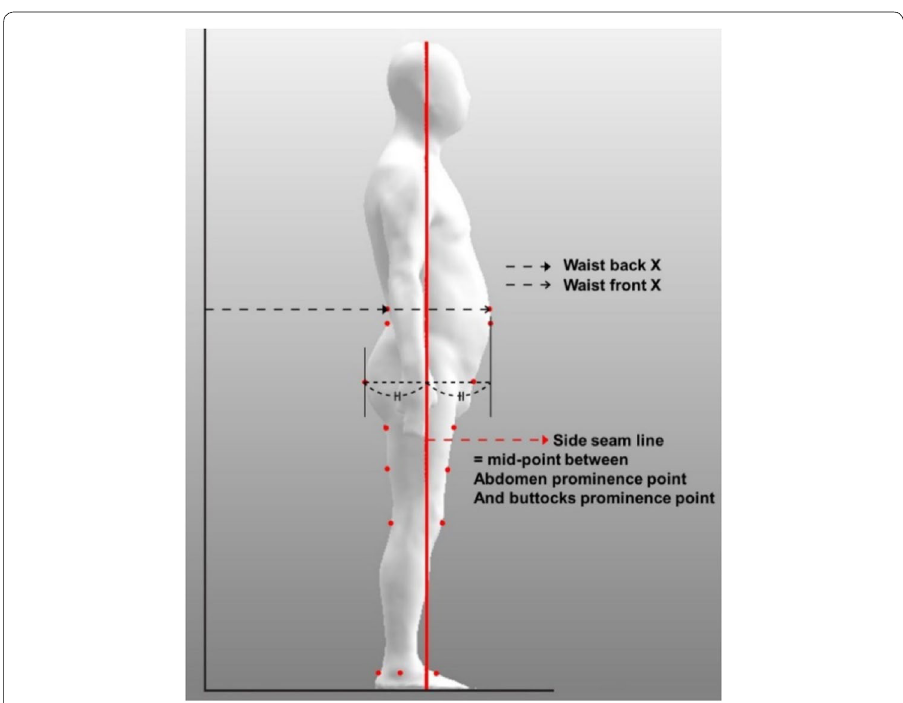
Fig. 1 Definition of side seam and front/back X